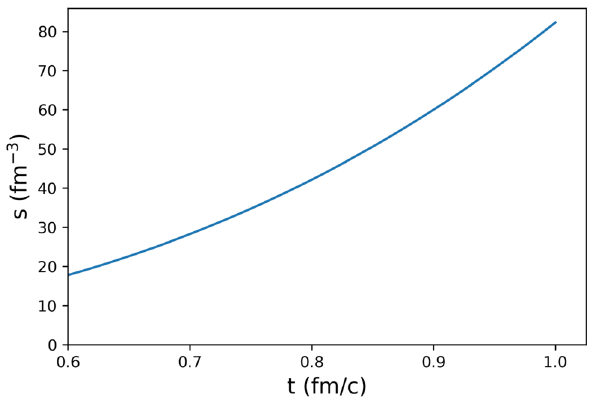
Fig. 4 Entropy density of the thermal bath as a function of time